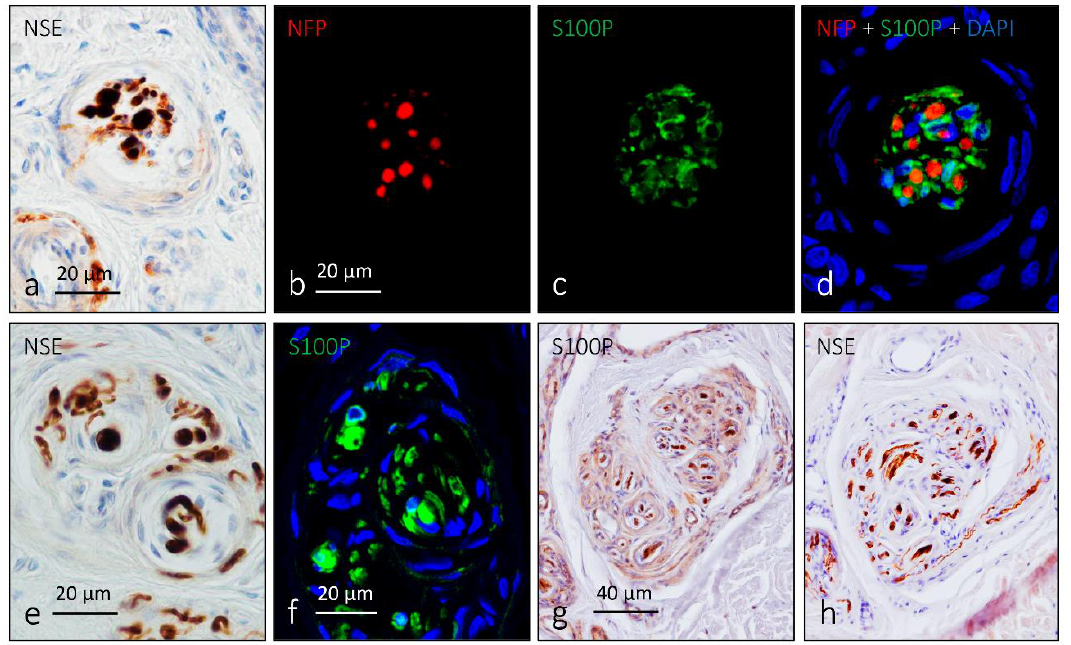
Figure 9. Immunohistochemical localization of neurons specific enolase (NSE), neurofilament protein (NFP) and S100 protein (S100P) in possible Krause corpuscles ( a – d ), Golgi–Mazzoni corpuscles ( e , f ) and a cluster of small lamellar corpuscles ( g , h ). Axons display strong immunoreactivity for NSE and NFP, and Schwann-like cells are S100P-positive. ( b – d ) double immunofluorescence demonstrating NFP- and S100P-immunoreactivity in axons and glial cells, respectively in possible Krause corpuscles.